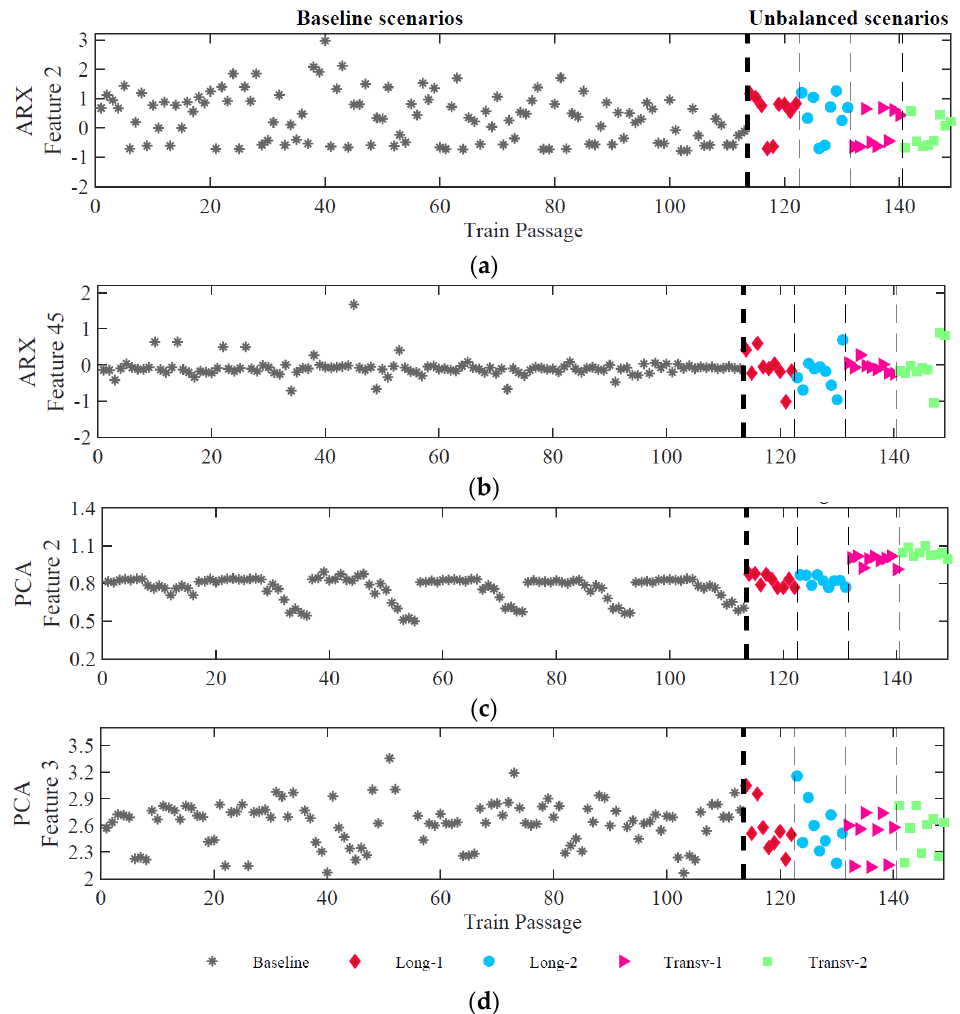
Figure 11. Feature extraction for accelerometer 1 baseline and unbalanced scenarios: ( a ) ARX model, feature 2; ( b ) ARX model, feature 45; ( c ) PCA model, feature 2; ( d ) PCA model, feature 3.